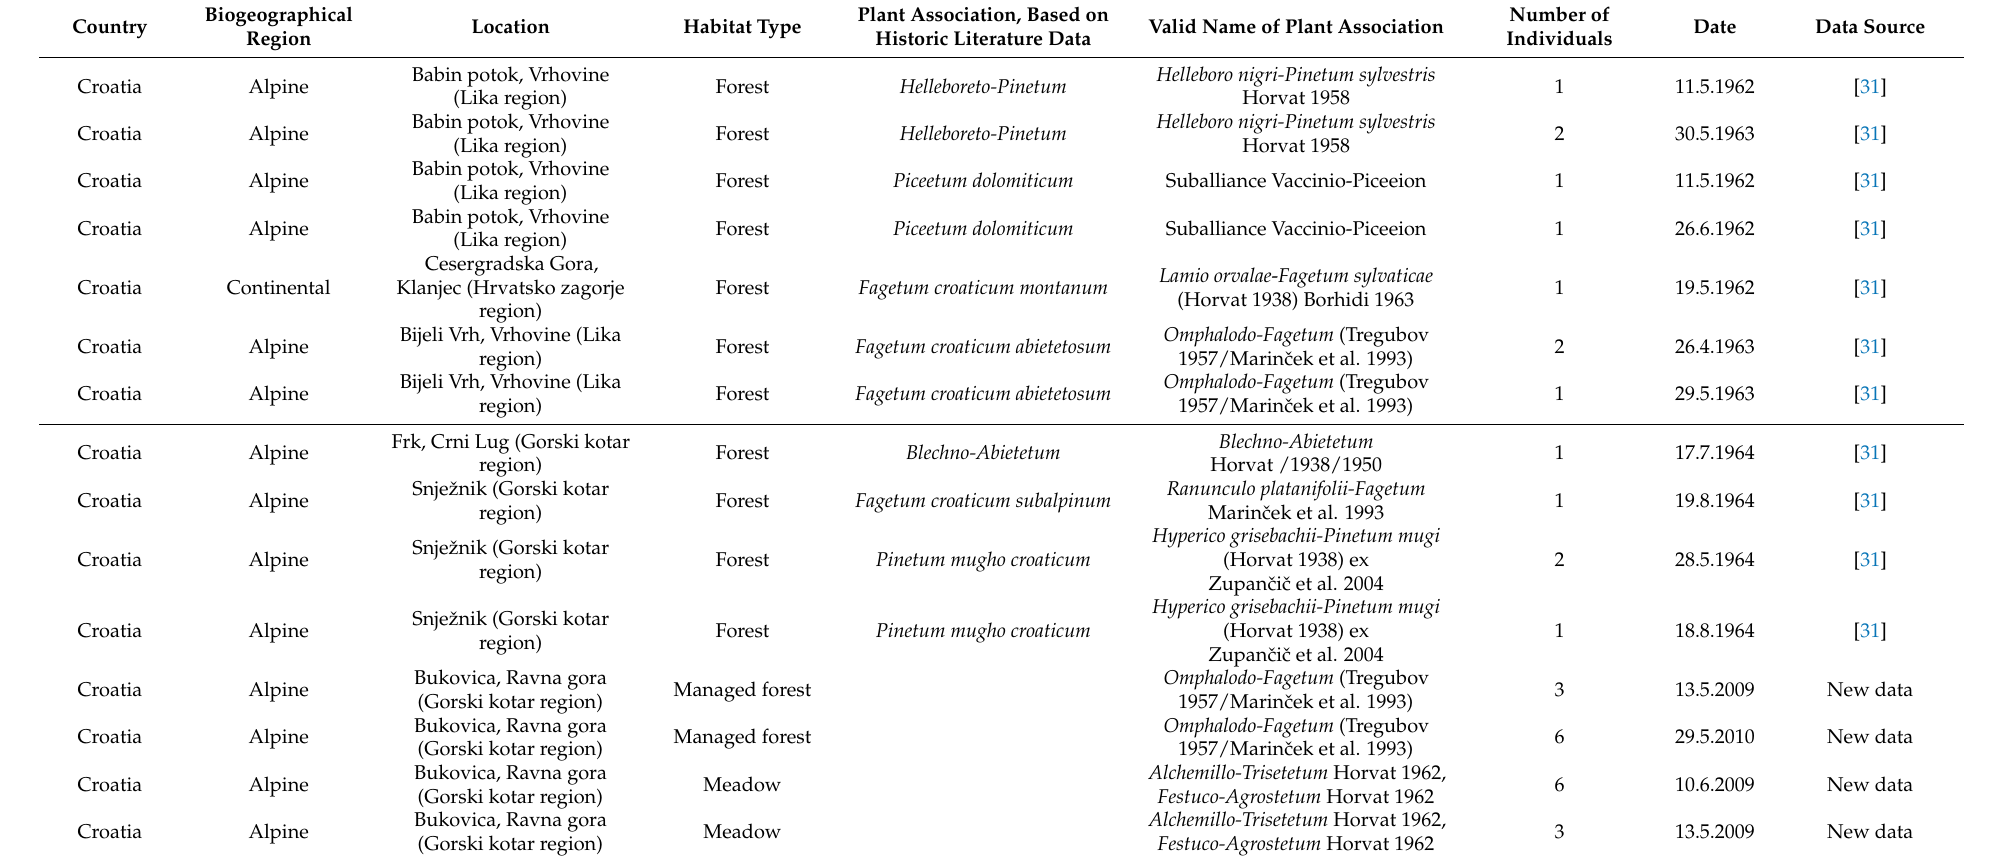
Table A1. List of known records of the Dinaric land leech ( Xerobdella anulata